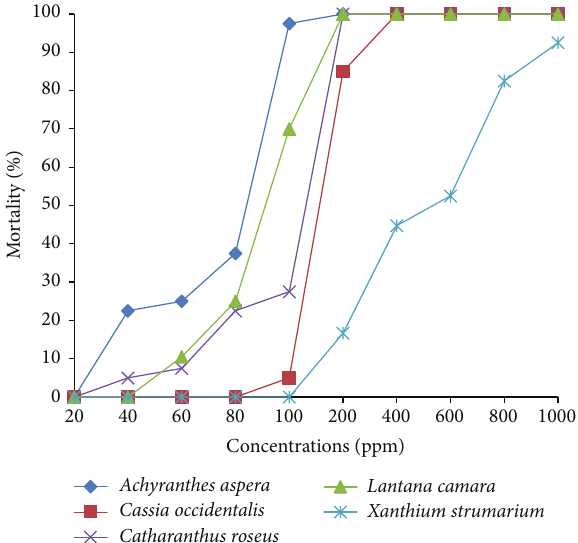
Figure 3: Percent mortality of hexane stem extracts of different selected plants at different concentrations against early IV instars of Ae. aegypti.